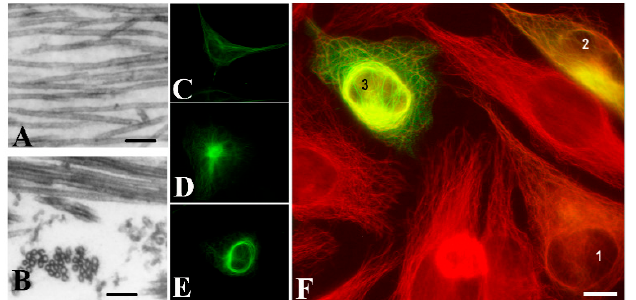
Figure 1. Tubulin Polymerization Promoting Protein (TPPP/p25)-derived ultrastructural organization of microtubules. Images of microtubules without or with human recombinant TPPP/p25: ( A ) control, ( B ) TPPP/p25-induced microtubule bundling, as visualized by electron microscopy. HeLa cells expressing pEGFP-TPPP/p25 (green): ( C ) control, ( D ) aggresome; ( E ) perinuclear cage; HeLa cells transiently transfected with EGFP-TPPP/p25 (green): ( F ) different expression levels produce distinct microtubule (red) ultrastructures: ( 1 ) alignment to the microtubule network, ( 2 ) aggresome formation, ( 3 ) perinuclear cage as visualized by immunofluorescence microscopy (selected from [9] and [8]). Scale bar: 100 nm ( A , B ); 10 μ m ( C – F ). TPPP/p25 is an intrinsically disordered protein without a well-defined 3D structure, whose middle, highly flexible CORE region is straddled by the unstructured N- and C-termini [10]. Specific binding segments in the disordered TPPP/p25 have been identified, such as a zinc finger motif, a consensus GTP-binding domain and phosphorylation sites ([11] and references therein) (Figure 2).